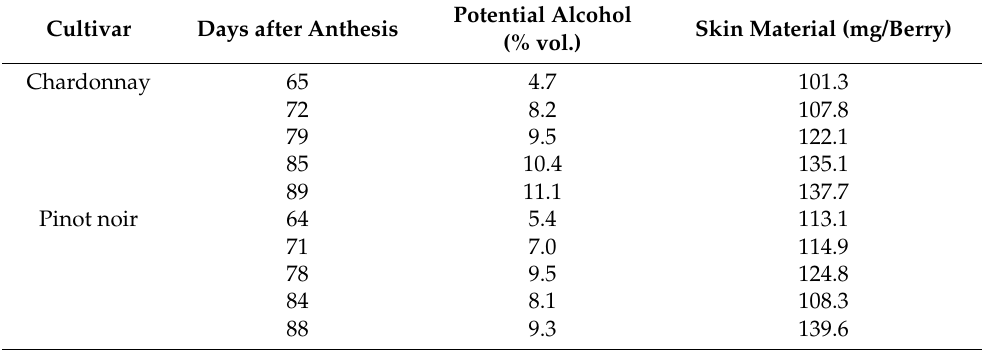
Table 1. Grape berry